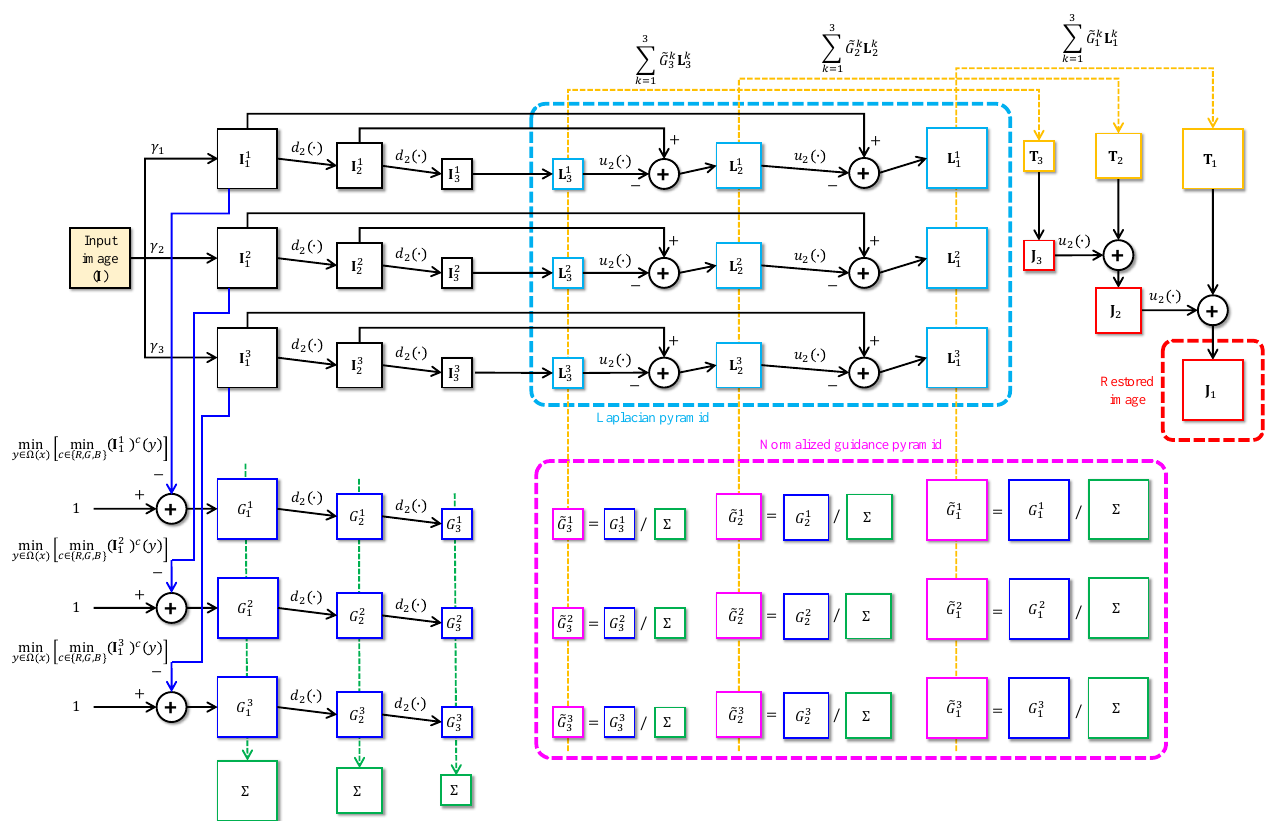
Figure 4. Illustration of the multi-scale image dehazing in Algorithm 1 with K = 3 and N =